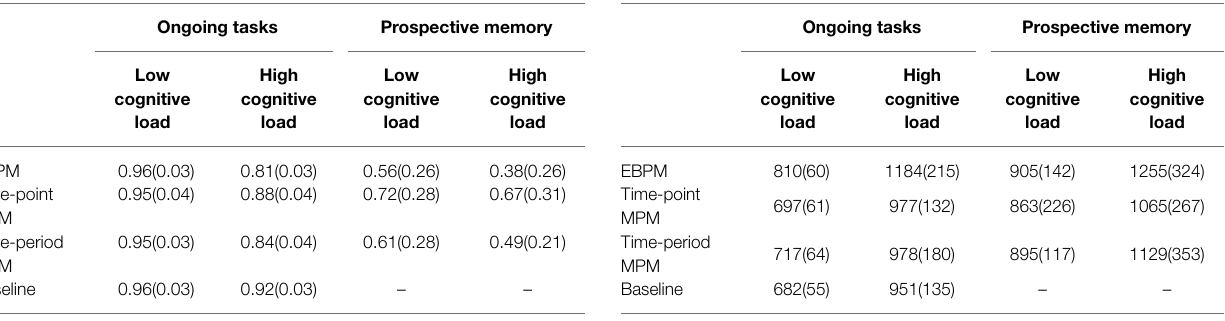
TABLE 1 | The accuracy of ongoing task and prospective memory ( M ± SD ). TABLE 2 | The response time of ongoing tasks and prospective memory ( M ± SD